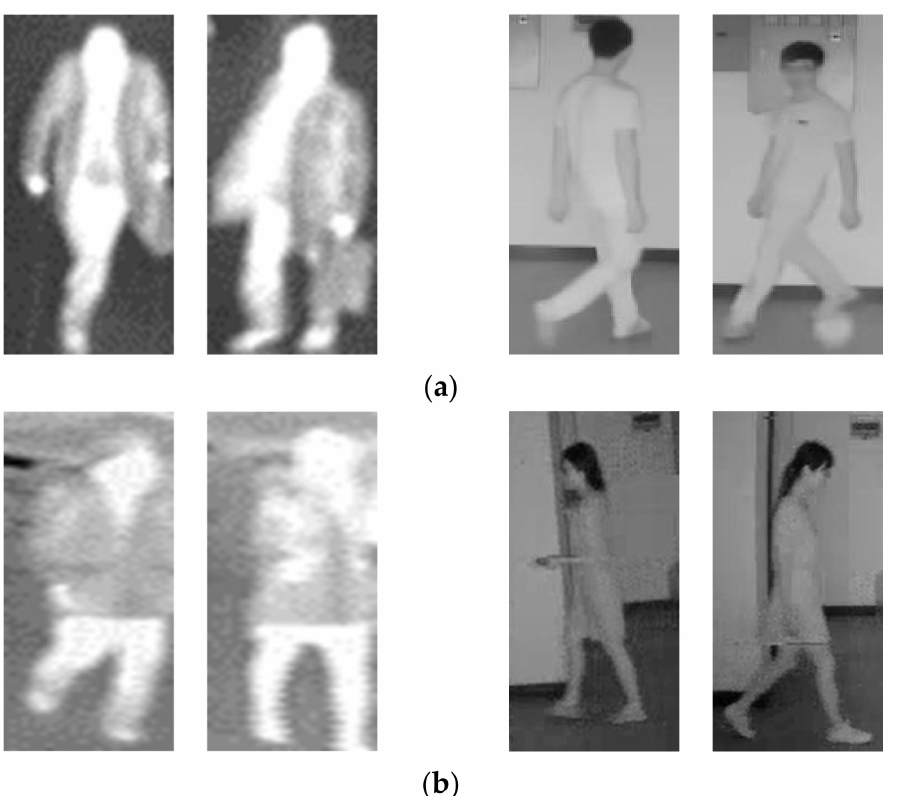
Figure 16. Examples of ( a ) incorrect rejection from genuine matching and ( b ) incorrect acceptance from imposter matching.